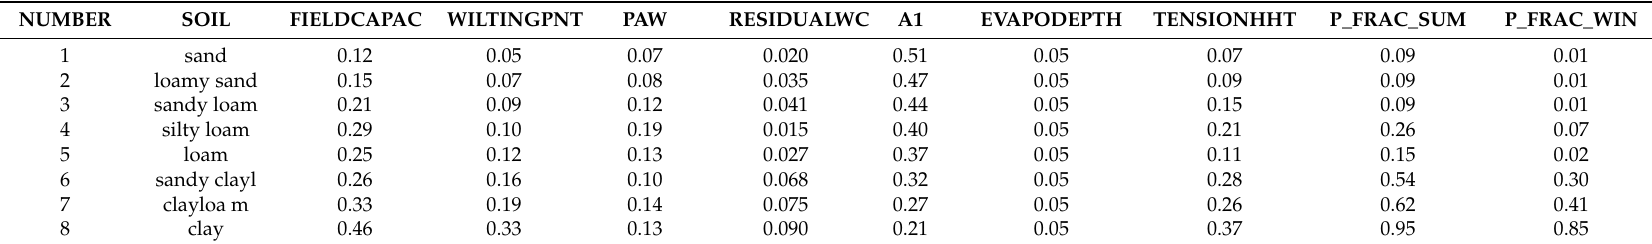
Table A2. WetSpass soil